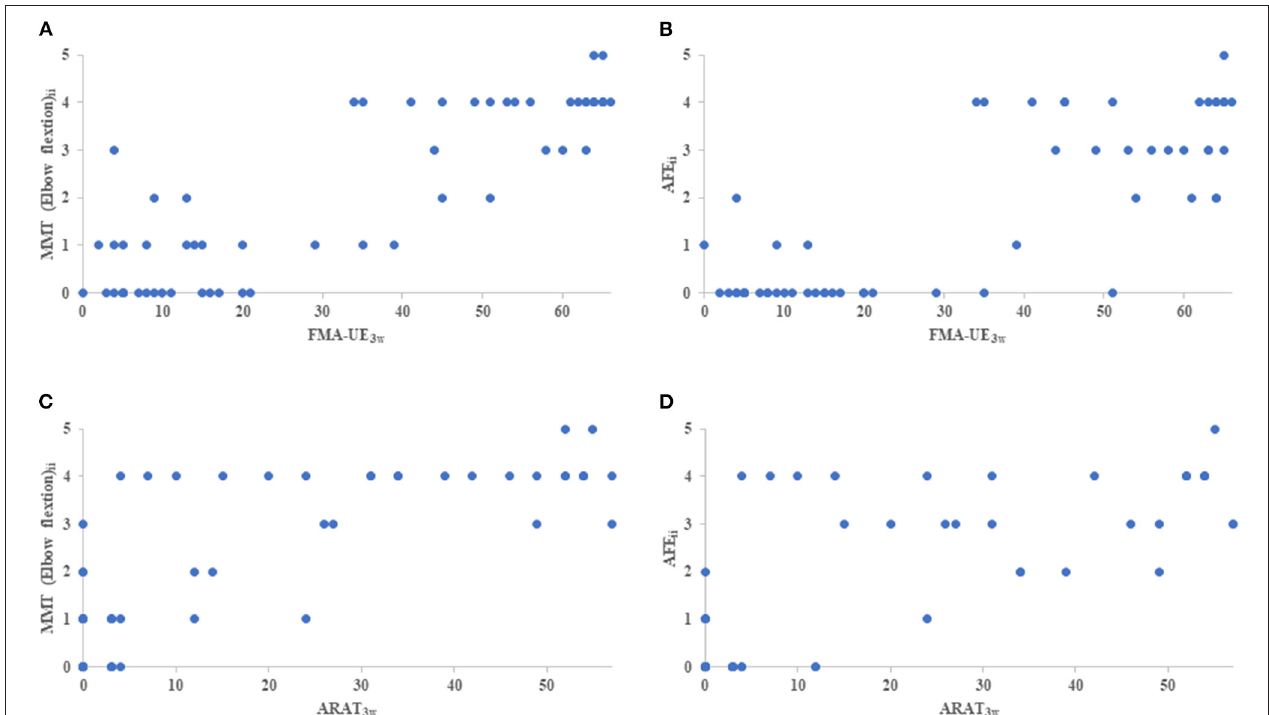
FIGURE 2 | The correlation plot between initial impairment and clinical assessment of 3 weeks. (A) indicates MMT elbow flexion initial impairment (MMT elbow flexion ii ) vs